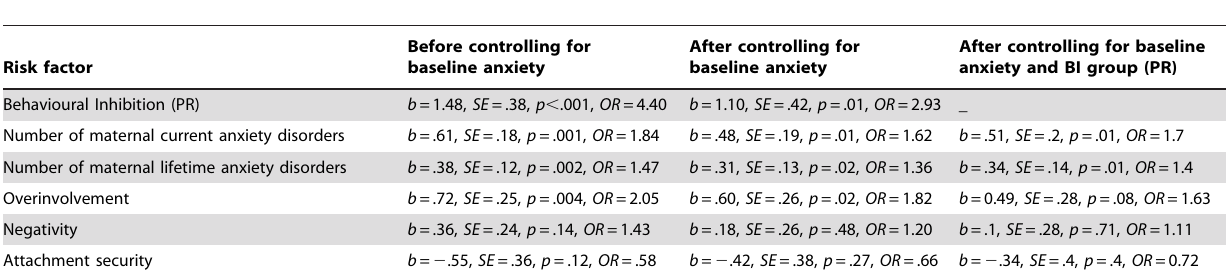
Table 2. Results of logistic regressions to assess the effect of each risk factor on the presence of an anxiety diagnosis at 5-year